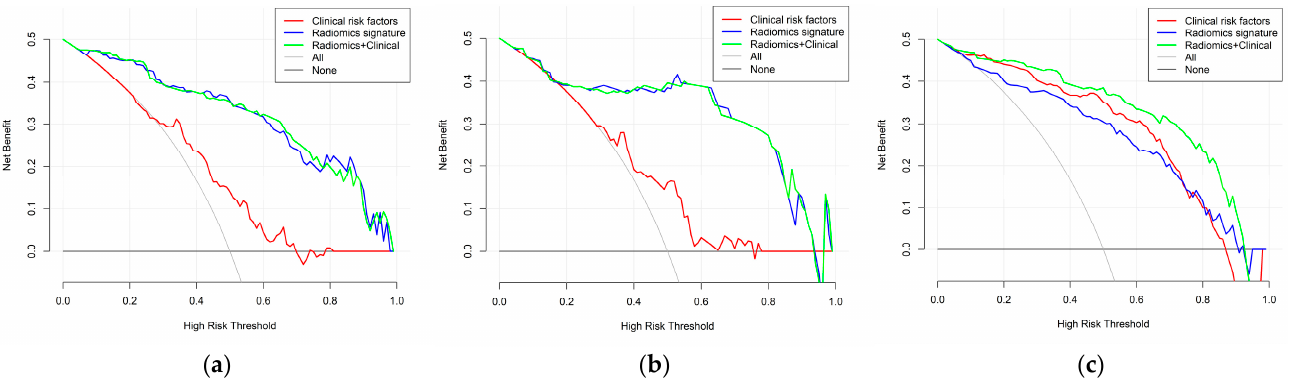
Figure 11. Decision curve analysis of the three models: ( a ) un-SMOTE training cohort, ( b ) test cohort and ( c ) TCGA/TCIA validation cohort.